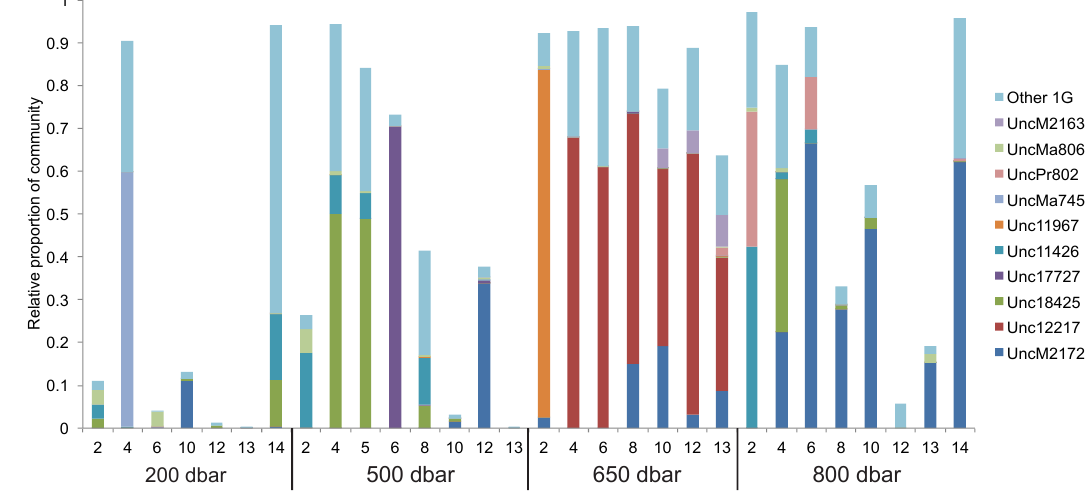
Figure 3. Relative abundance of subcluster 1G over pressure levels (depths) and stations. Each bar represents the relative abundance of subcluster 1G in the total community for each sample. Samples are arranged by station within each of the pressure levels sampled. Blastp was used to assign OTUs to a top hit in the nifH reference database. The major sequence types in the nifH database found in subcluster 1G are shown with different